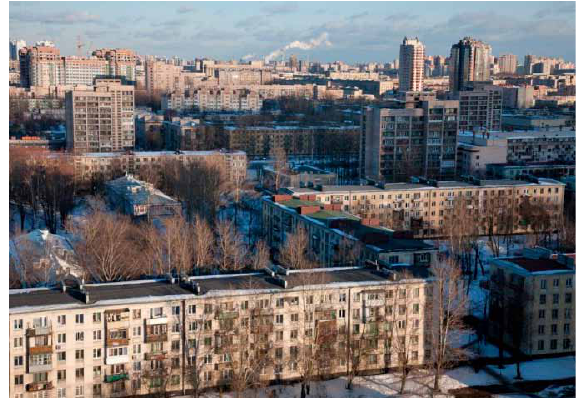
fig. 2. uSSr economical types of houses